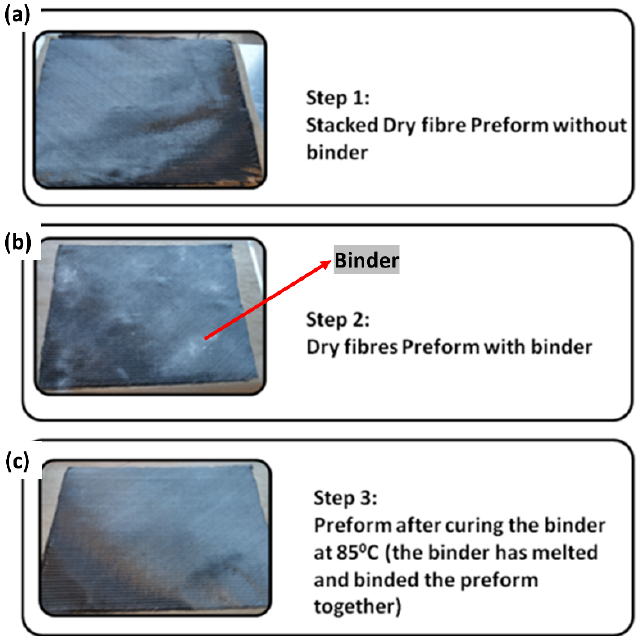
Figure 5. Preform binding steps for a tubular section.